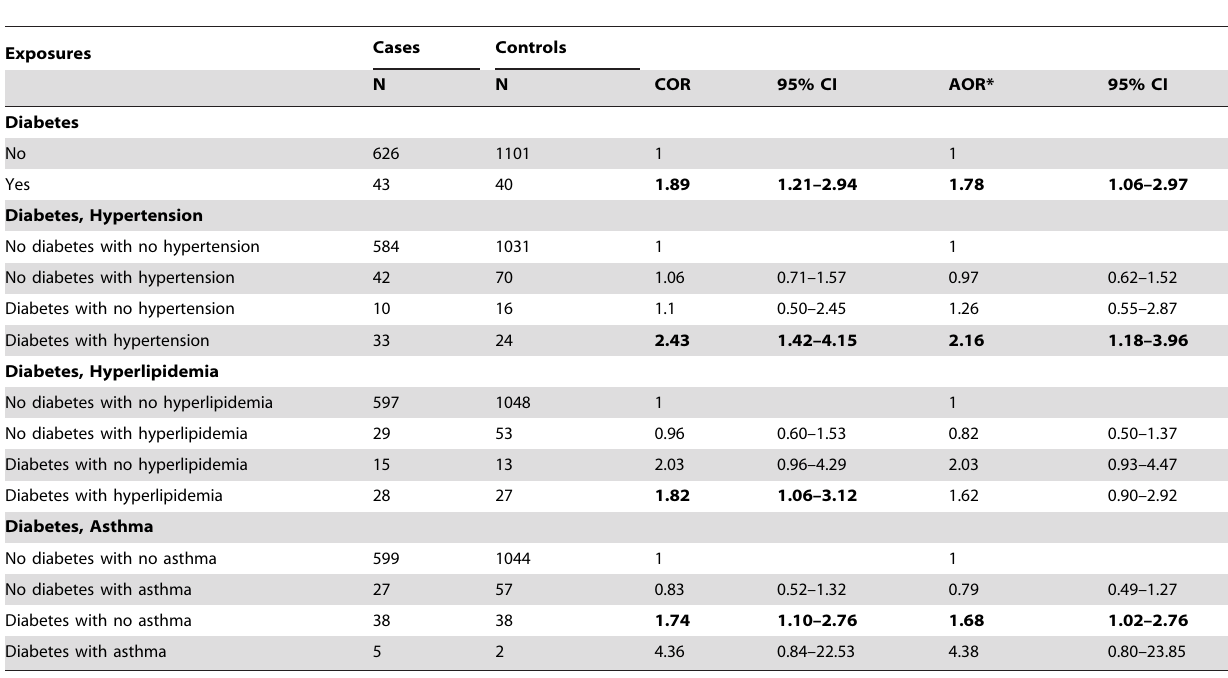
Table 4. Crude and adjusted odds ratios of the association of DHF with multiple co-morbidities in year 2007–2008 epidemic.